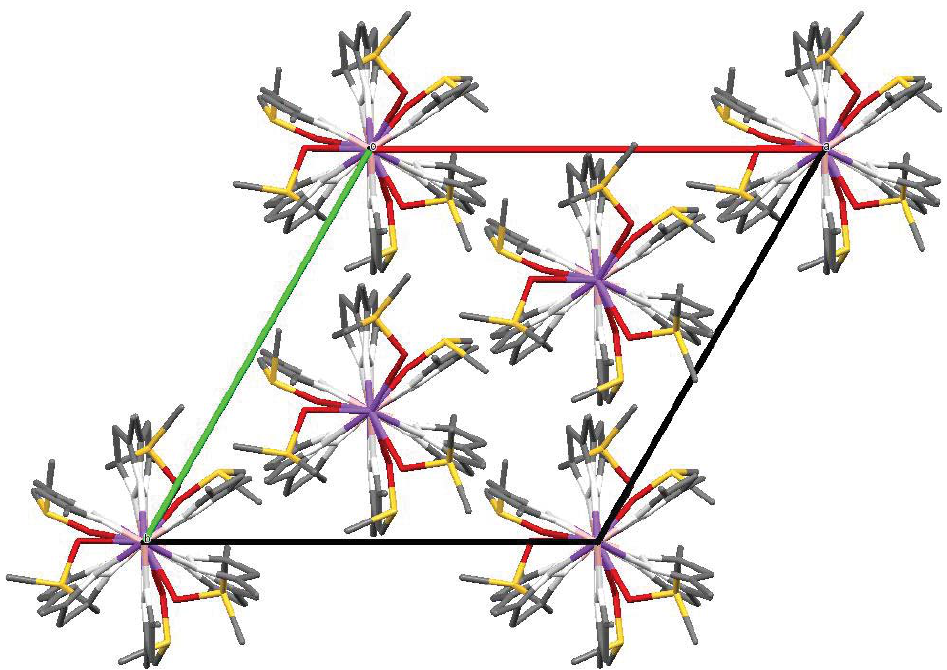
Figure 5: Mercury representation showing the crystal packing of 2 along the c -axis (hydrogen atoms are omitted for